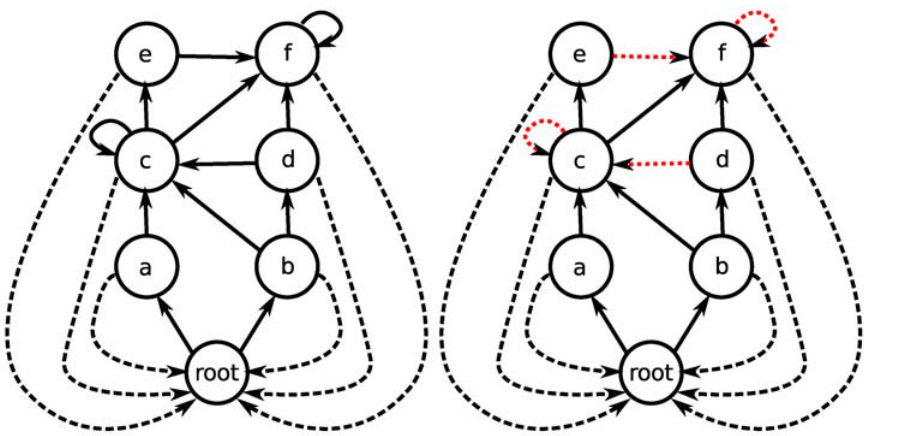
Figure 1. Modification of food webs from ecological considerations to satisfy the two constraints required for application of the EIG algorithm. Left) A special node is added to the food web by connecting this ‘‘root’’ to the primary producers. Every species in turn connects to the root to represent the buildup of detritus (dashed line). Right) The analysis can be improved by removing the ‘‘redundant’’ connections that do not contribute to robustness (dashed, in red).